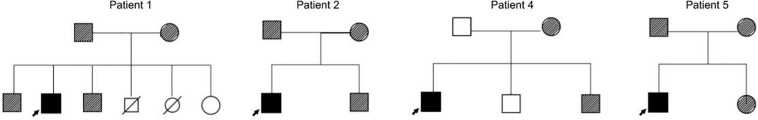
Pedigree charts from patients 1, 2, 4, and 5. : Heterozygous FH. : Homozygous FH.